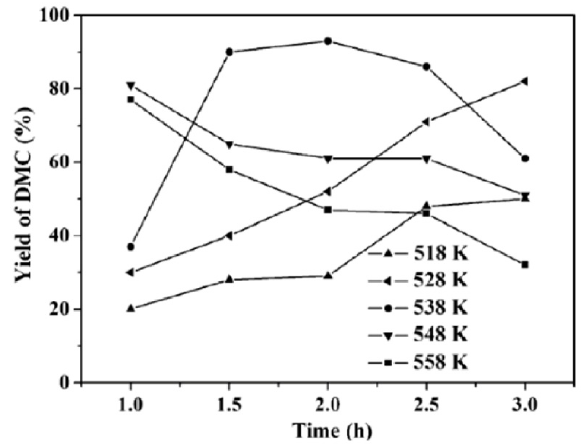
Figure 11. Effect of temperature and time on DMC yield during alcoholysis of urea in the presence of supercritical methanol. [Reaction conditions used: molar ratio methanol/urea = 25, reactor loading = 285 µL, reaction pressure = 6.4 MPa (518 K), 8.0 MPa (528 K), 9.2 MPa (538 K), 10.0 MPa (548 K), and 10.8 MPa (558 K)]. (Reprinted/adapted with permission from Ref. [89], 2014, Elsevier).